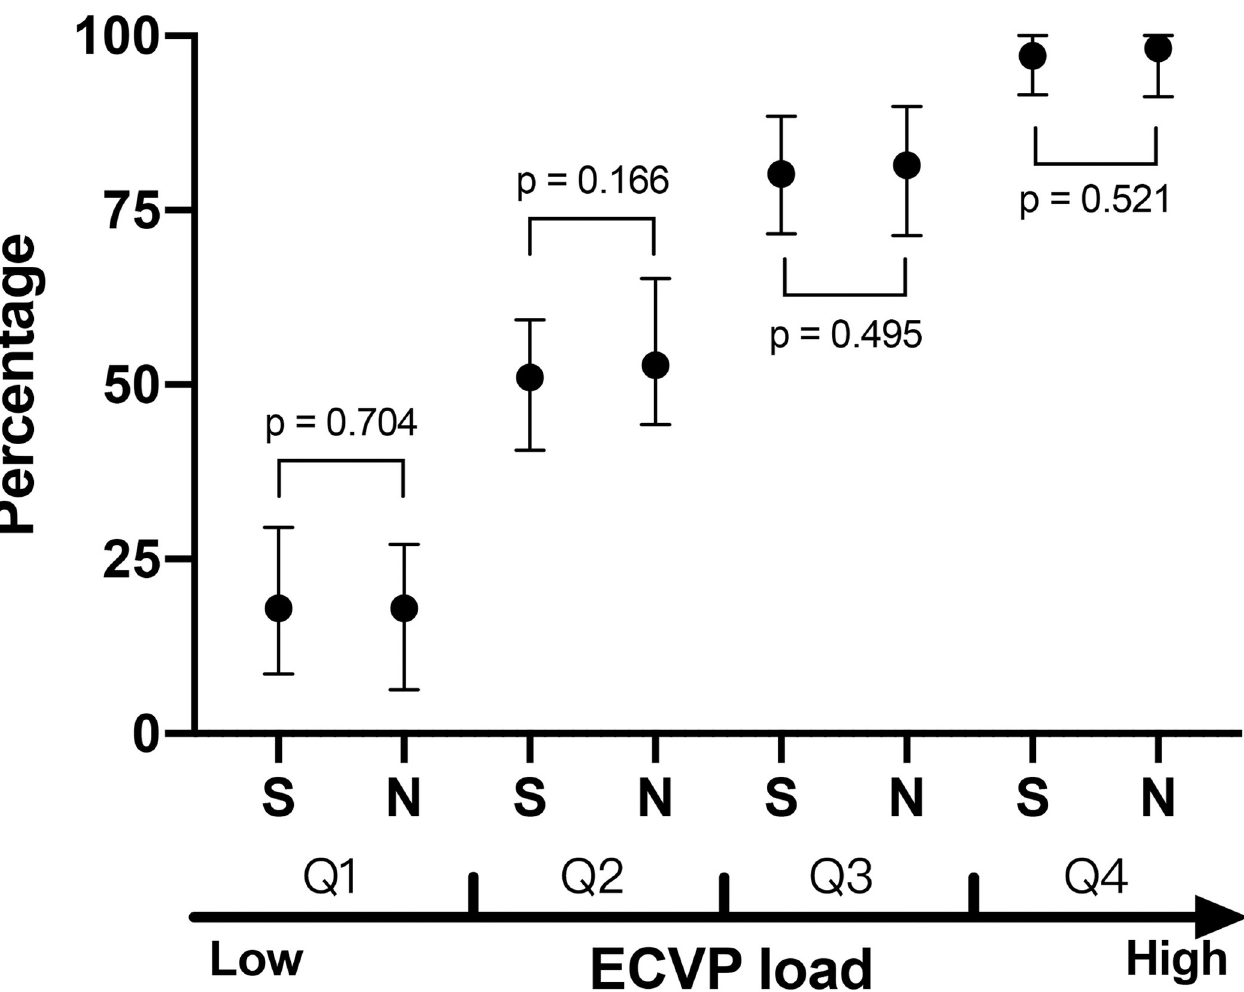
Fig 6. Comparison of the duration of elevated central venous pressure in patients with different elevated central venous pressure load. Patients were divided into four subgroups (Q1 to Q4) according to the quartiles of elevated central venous pressure (ECVP) load. Data were presented as median and interquartile range. The percentage of ECVP duration in total CVP duration is presented on the y-axis and compared between survivors and non-survivors, assuming that patients had comparable ECVP loads within their subgroups. No significant difference was observed in each subgroup. S: survivor, N: non-